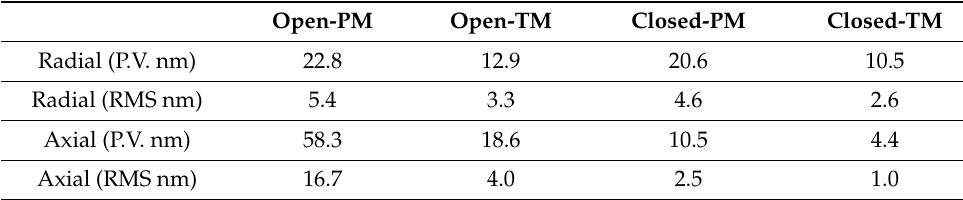
Figure 6. Surface-shape-fitting nephograms after gravity deformation analysis: ( a ) open-PM-radial; ( b ) open-TM-radial; ( c ) closed-PM-radial; ( d ) closed-TM-radial; ( e ) open-PM-axial; ( f ) open-TM-axial; ( g ) closed-PM-axial; ( h ) closed-TM-axial. Table 4. Surface-shape-fitting results after gravity deformation